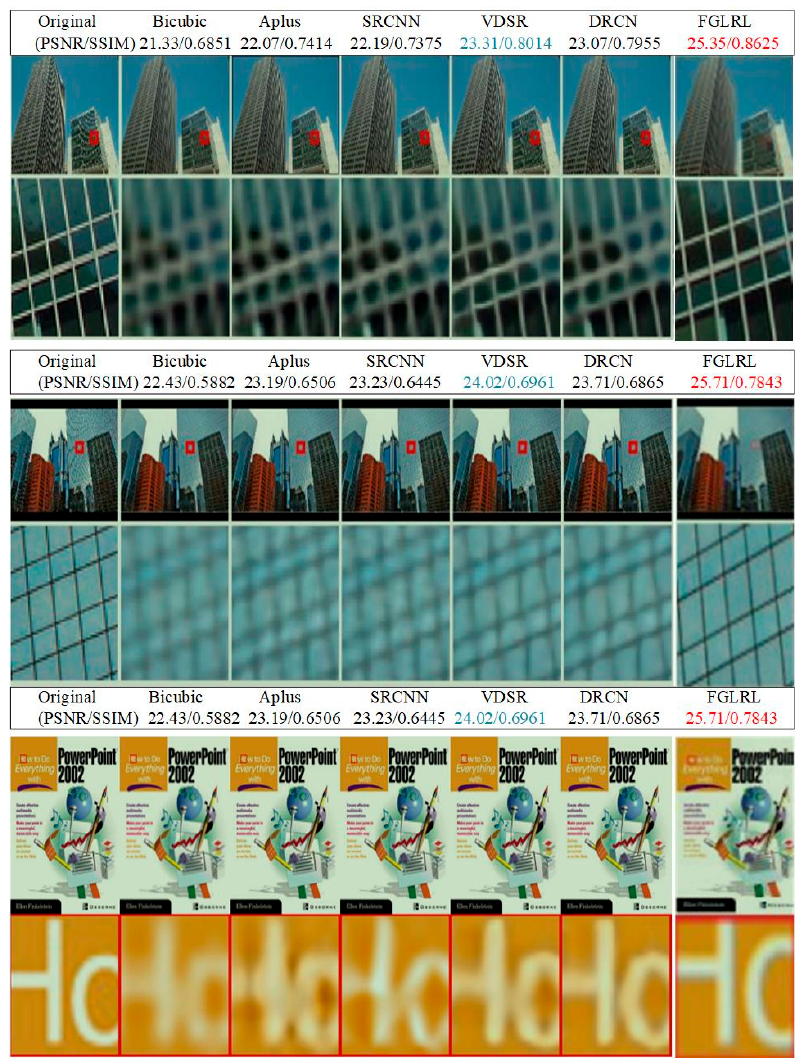
Comment: Red color indicates the best performance of all methods and blue color indicates the second-best performance of all methods.